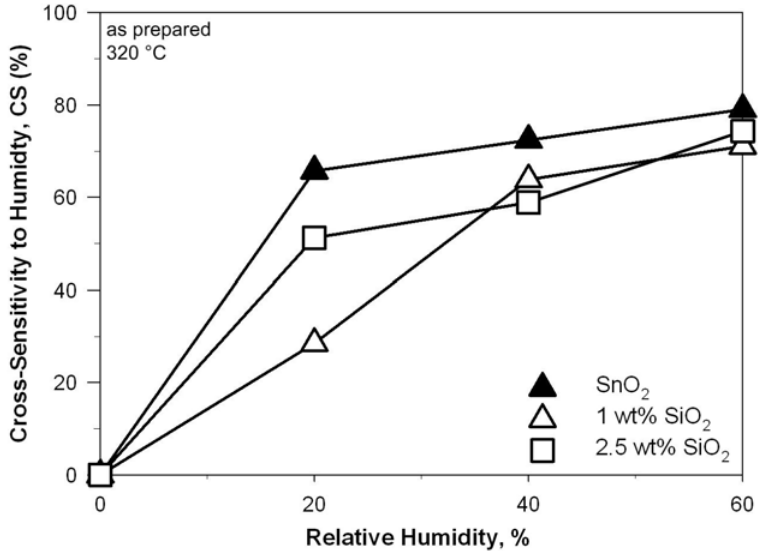
Figure 9. Cross-sensitivity to relative humidity (20 °C) of as prepared SnO (solid triangles), and of 1 wt% (empty triangles) and 2.5 wt% (squares) SnO nanocomposites at 320